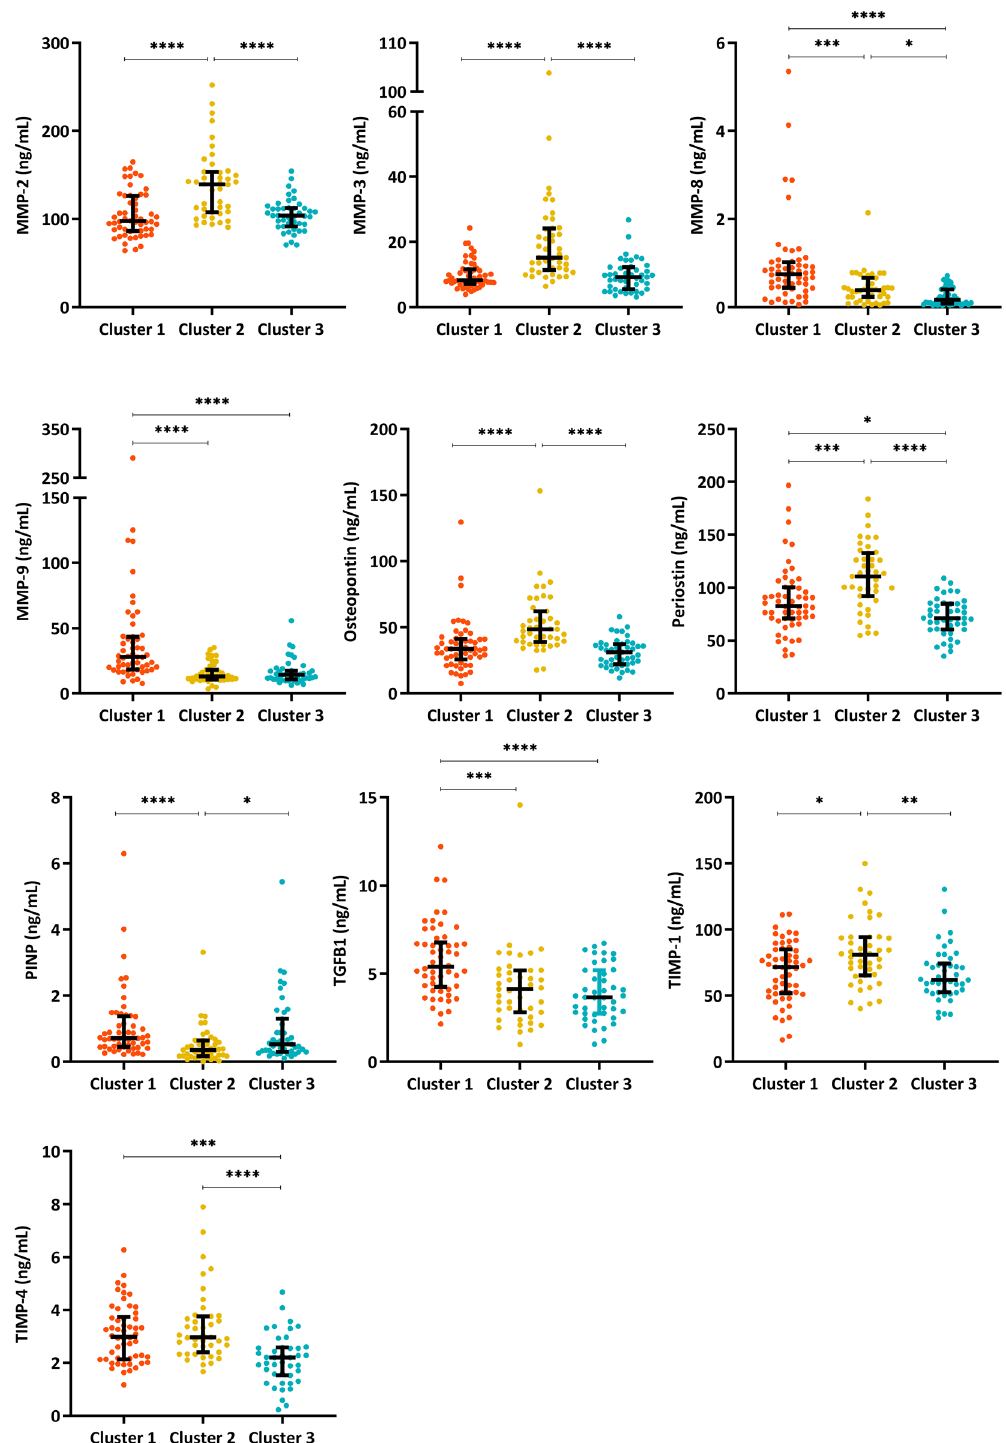
Figure 3. Extracellular matrix biomarker levels between clustered groups. Kruskal–Wallis test with Dunn’s multiple comparisons was performed to identify significant difference in ECM biomarker levels between patient clusters. Median (IQR) is plotted for each graph.* p < 0.05, ** p < 0.01, *** p < 0.001, **** p < 0.0001. This image was created using GraphPad Prism software, version 7.04 for Windows, www. graph pad.